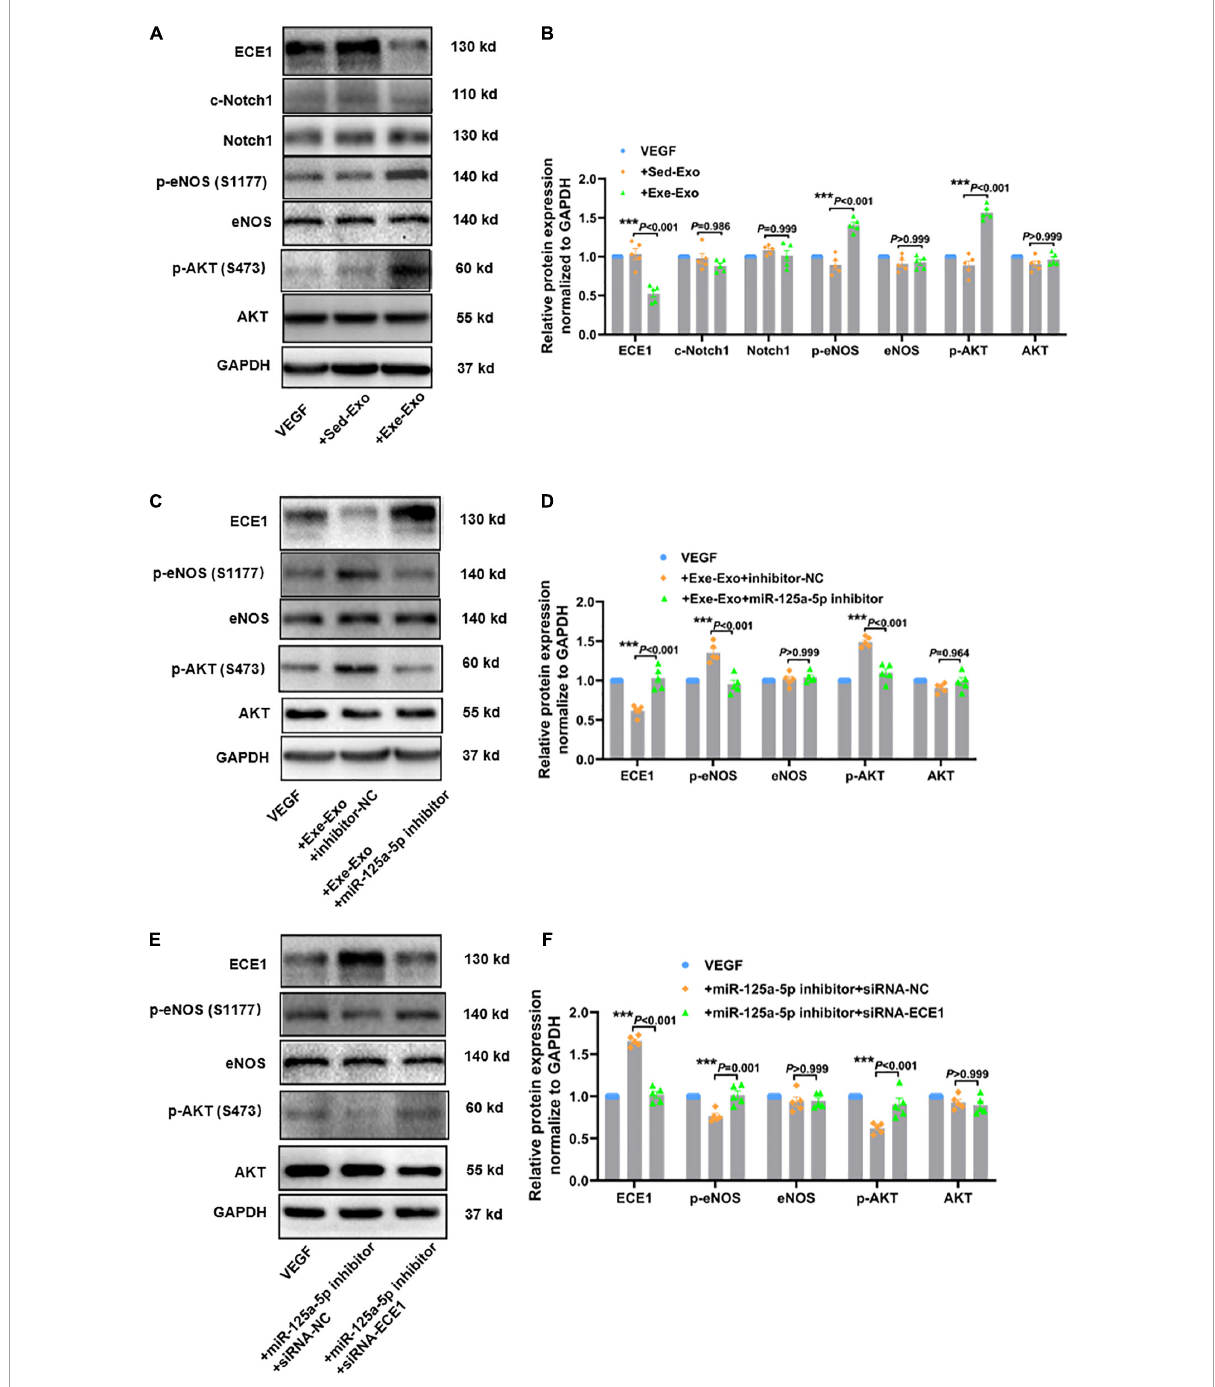
FIGURE6 Exercise-derived circulating exosomes activate the AKT/eNOS signaling pathway via miR-125a-5p targeting ECE1. The cells were incubated with Sed-Exo (50 µ g/ml) or Exe-Exo (50 µ g/ml) for 48 h, starved for 6 h and stimulated with VEGF165 (100 ng/ml) for 20 min. Exe-Exo downregulated ECE1 expression and activated AKT and eNOS phosphorylation but had no effect on Notch1 cleavage. Representative blots (A) and quantitative analysis (B) of ECE1, Notch1, c-Notch1, AKT, p-AKT, eNOS and p-eNOS protein expression determined via western blotting. Cultured HUVECs were incubated with Exe-Exo (50 µ g/ml) and transfected with an miR-125a-5p inhibitor (100 nM) or inhibitor NC (100 nM) for 48 h, followed by starvation for 6 h and stimulation with VEGF165 (100 ng/ml) for 20 min. Representative blots (C) and quantified data analysis (D) of ECE1, AKT, p-AKT, eNOS and p-eNOS protein expression determined by western blotting. HUVECs were co-transfected with miR-125a-5p inhibitor and siRNA-ECE1 or siRNA-NC for 48 h. Then the cells were treated with or without starvation for 6 h followed by stimulation with VEGF165 (100 ng/ml) for 20 min. Representative blots (E) and quantified data (F) of ECE1, AKT, p-AKT, eNOS and p-eNOS protein expression determined via western blotting. *** P < 0.001. Each experiment was repeated 5 times. The data are means ±